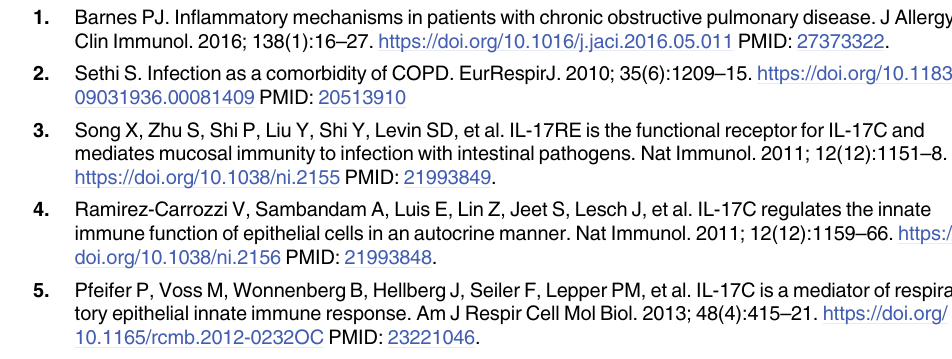
S1 Fig. IL-17C mediates chronic neutrophilic inflammation. WT and Il-17c-/- mice were exposed three times per week to NTHi at days 1, 3, and 5 within the first 4 weeks and once a week at day 1 in the following 8 weeks. (A) Numbers of total immune cells, neutrophils, mac- rophages, and lymphocytes were determined in BAL fluids 24 hours after the final exposure to NTHi (n = 3–4 per group). (B) Representative lung histology hematoxylin and eosin staining) and inflammatory score (n = 4 per group, scale bar: 200 μ m). Data were compared by unpaired Student’s t-test and are shown as the mean ± SD. � p < 0.05 and �� p <